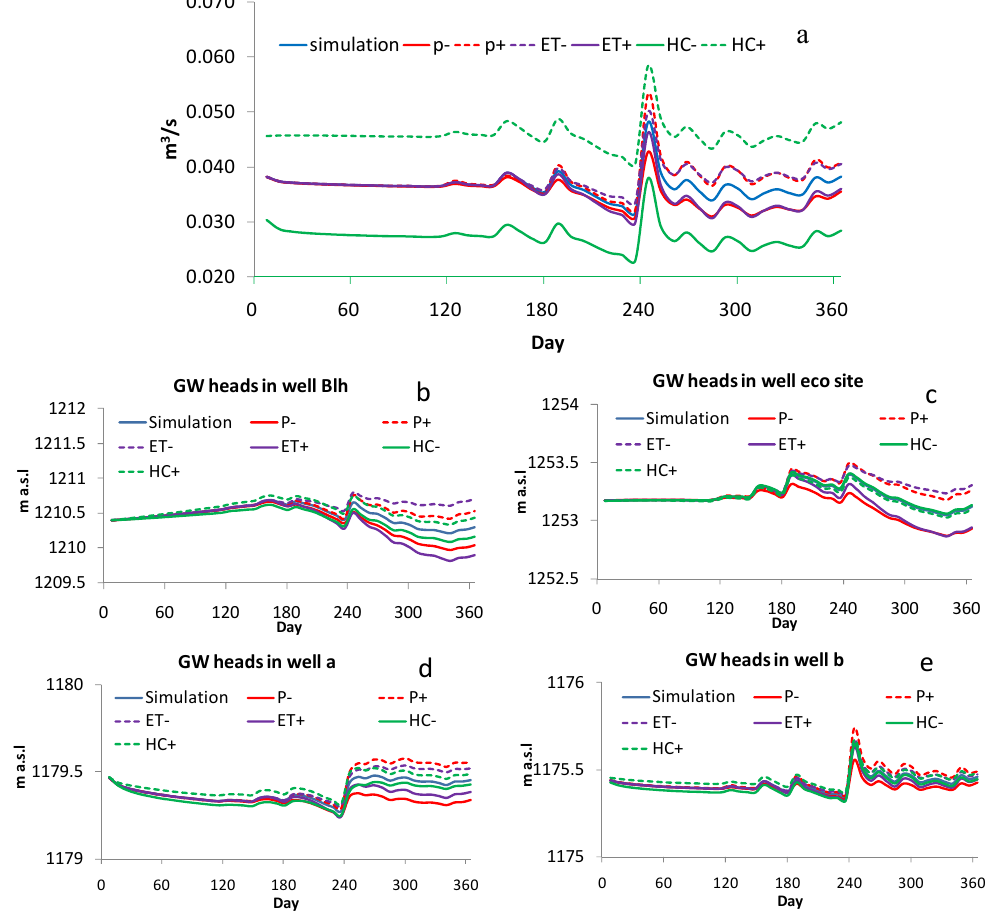
Figure 11. Sensitivity of computed stream discharge ( a ); and groundwater levels ( b – e ) to precipitation (P), evapotranspiration (ET), and hydraulic conductivity (HC); the sign ( − ) and (+) in the legend indicates the decreasing and increasing values by